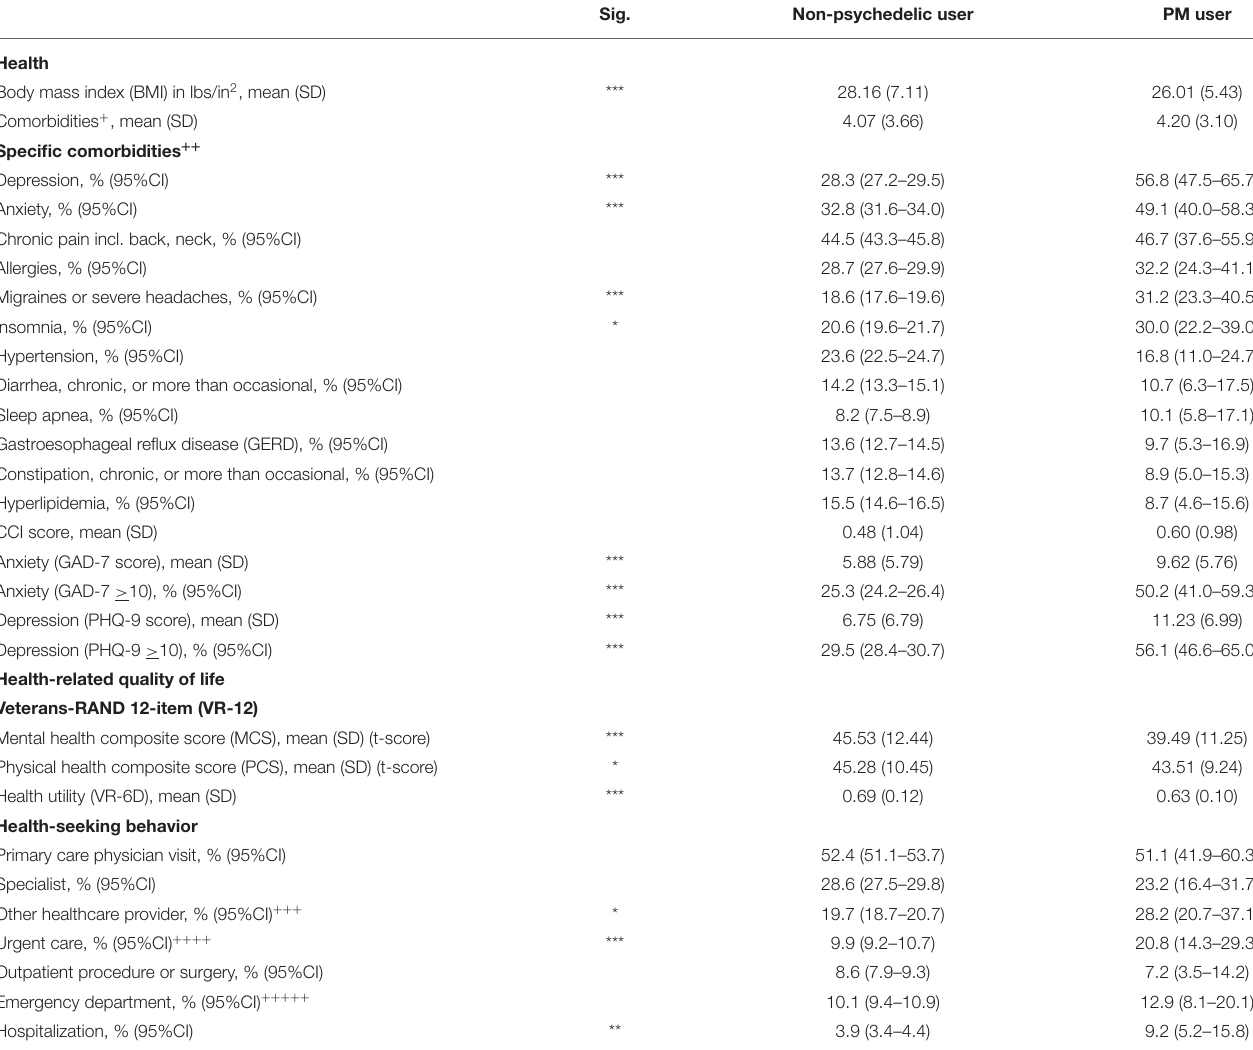
TABLE 2 | Descriptive non-psychedelic user and PM user health, quality of life and health-seeking behavior, US Adult population 2020/21 (weighted).